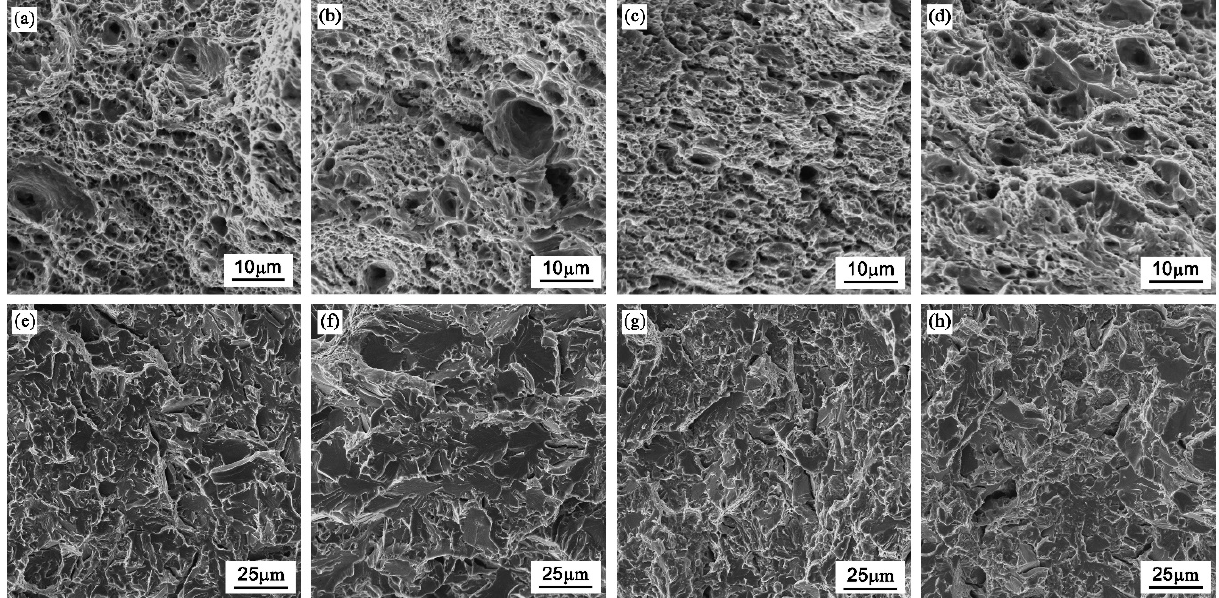
Figure 4. High magnification fractographs of crack-initiated area ( a – d ) and crack growth area ( e – h ) of S1 and S2 samples after Charpy impact at room temperature; ( a , e ) S1 before aging; ( b , f ) S2 before aging; ( c , g ) S1 aging 97 h at 580 °C; and ( d , h ) S2 aging 97 h at 580 °C.